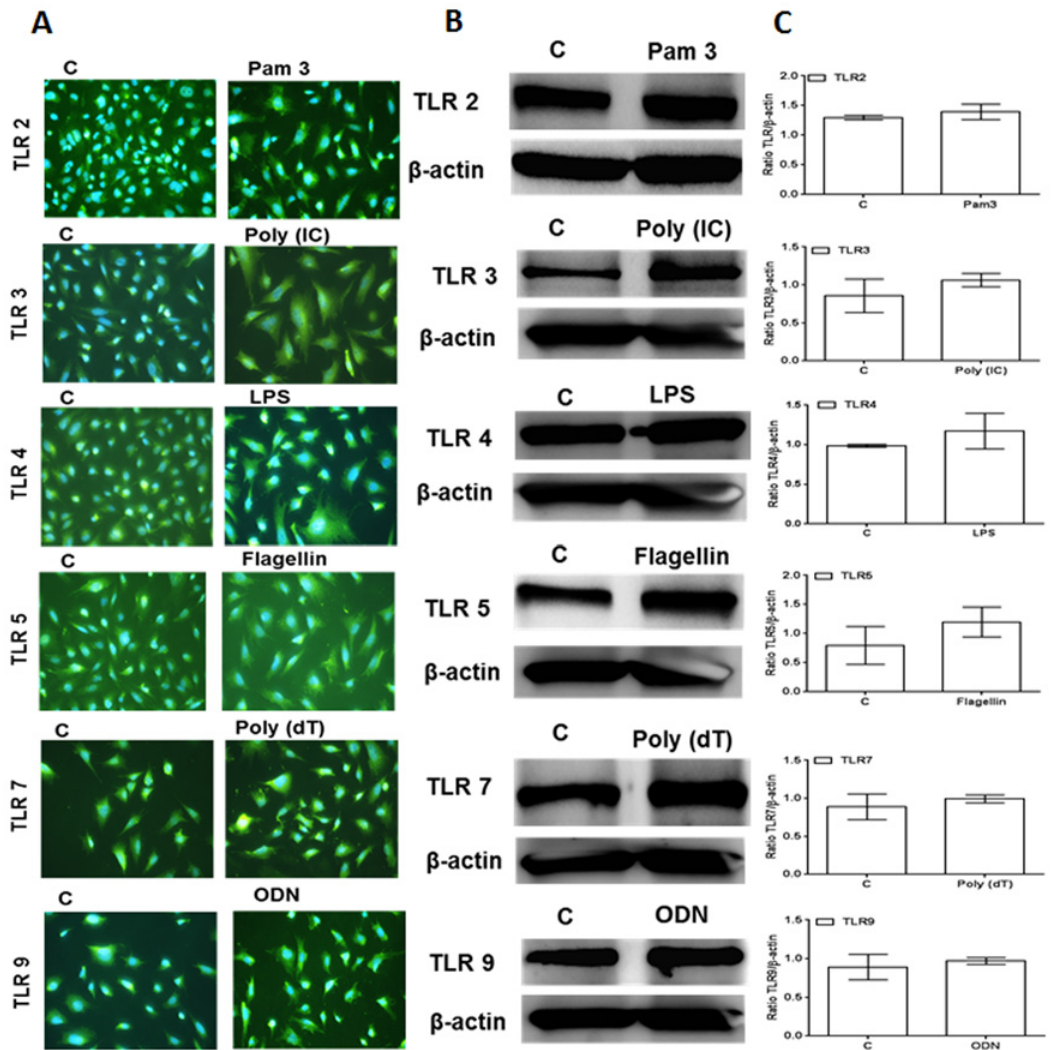
Fig 2. Western blot and IHC Analysis of TLR Expression in 661W cells. 661W cells were either left untreated or challenged with the indicated TLR ligands (as described in Fig. 1 legend) for 8h. Immunostaining was performed using specific antibodies to access TLR expression (A). In a separate experiment, cells were lysed using RIPA buffer and analyzed for TLRs expression by Western blot analysis using specific anti-TLR antibodies, with β -actin as a loading control (B). Band intensity was quantified by using Image J and presented as the relative band intensity of TLR vs. β -actin (C). Data points and error bars represent mean ± SD from two independent